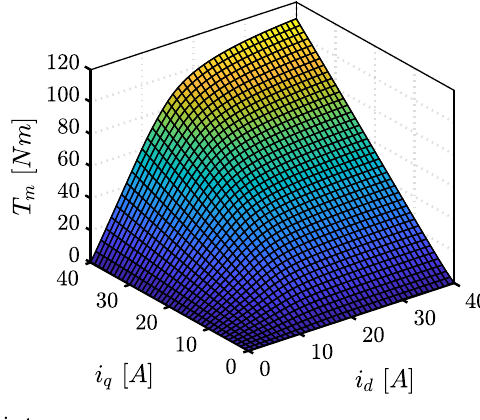
Figure 6. Electromagnetic torque map.